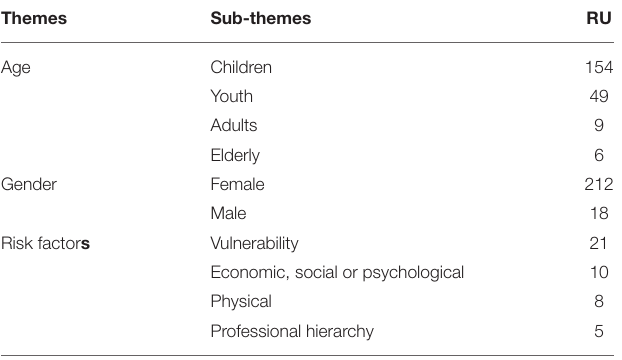
TABLE 3 | “Victims” Dimension’s themes and sub-themes.